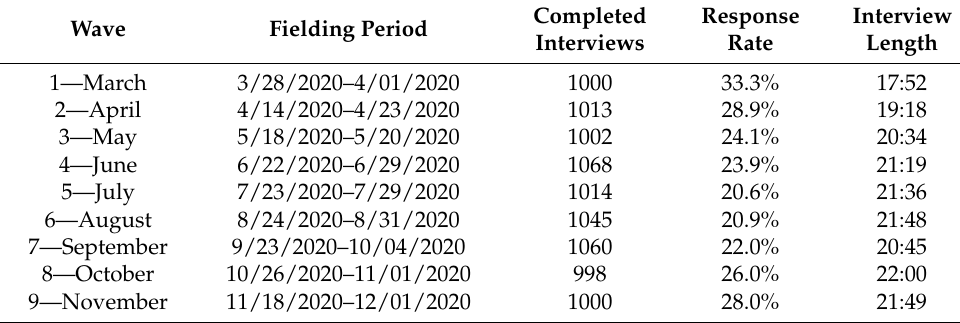
Table 1. COVID-19 Monitor Surveys: Size, Dates, Response Rates, and Length. Wave